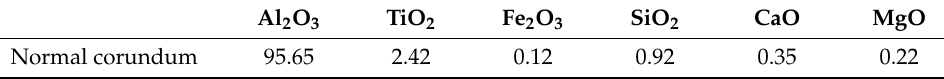
Table 3. Chemical composition of the normal corundum (sand) (wt.